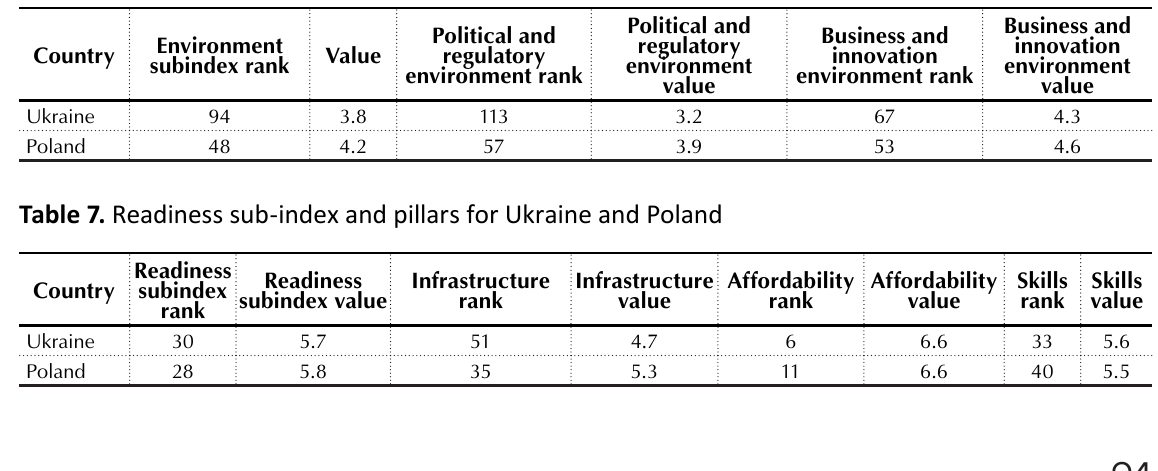
Table 6. Environment sub-index and pillars for Ukraine and Poland